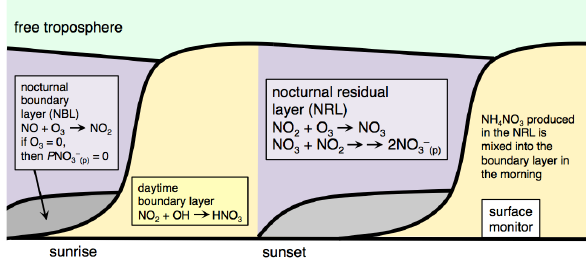
Figure 4. Simplified illustration of the diurnal evolution of the near- surface atmosphere as it relates to P NO − ics schematic adapted from Stull